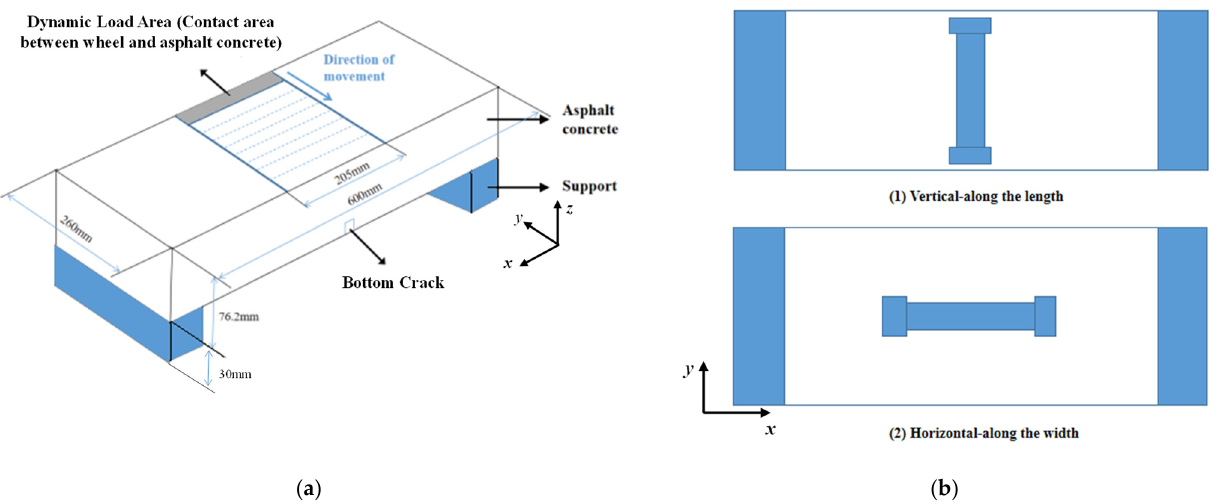
Figure 2. ( a ) Schematic of the numerical model of a dynamic load passing through the road surface. ( b ) Bottom view of the numerical model for showing sensor alignment.